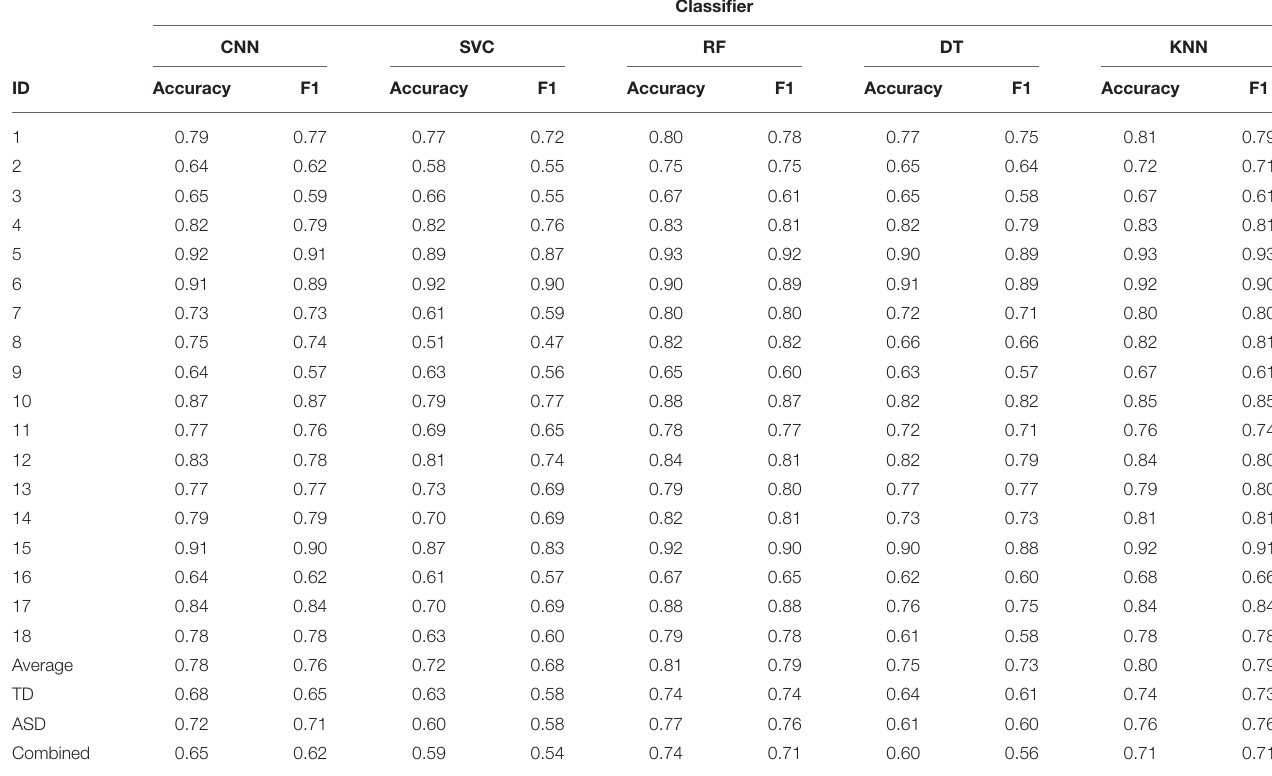
TABLE 6 | Performance metrics for all classifiers under individual and group